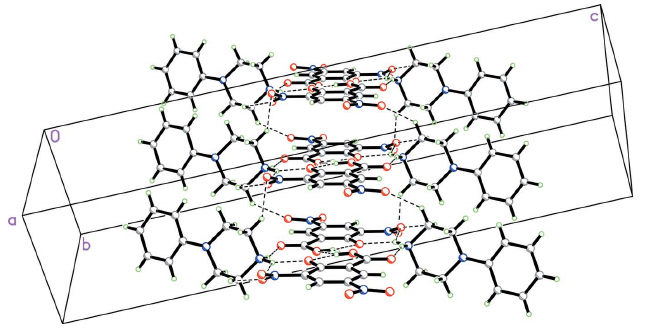
Figure 17 Packing diagram for 6 showing R 4